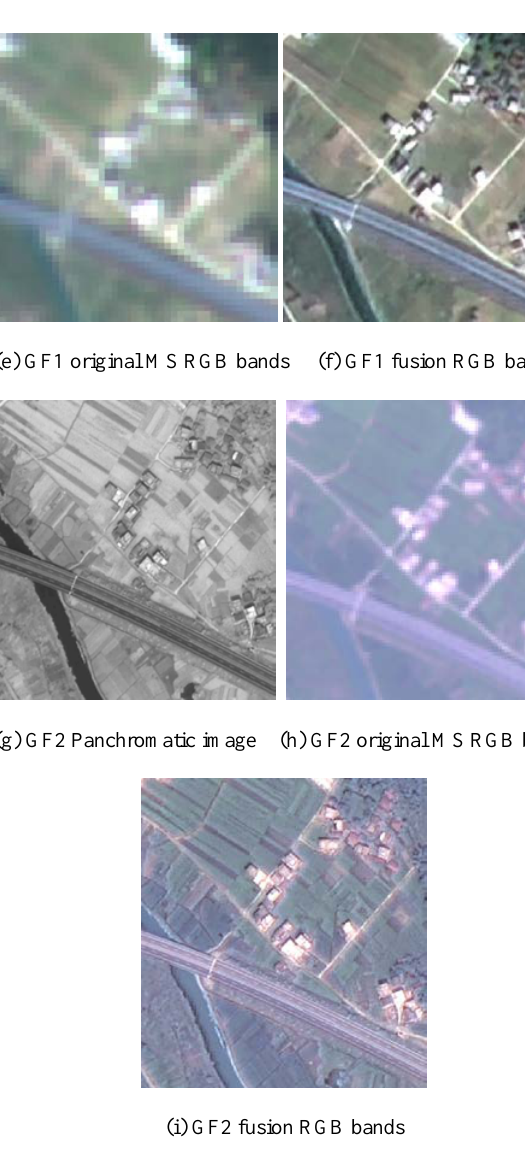
Figure 5.ZY3, GF1, GF2 panchromatic, multispectral and their corresponding fusion images.